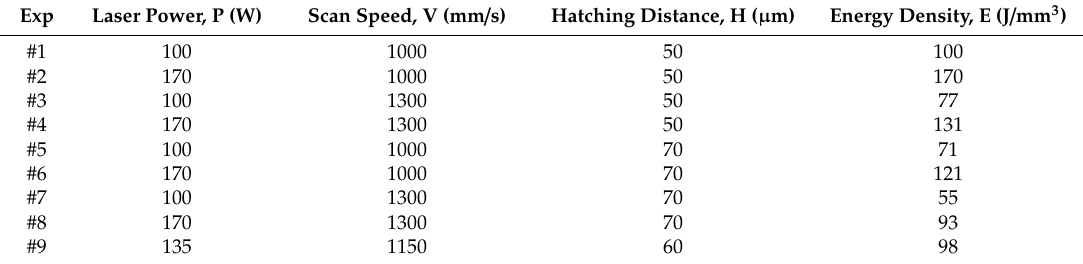
Table 2. Laser powder bed fusion processing parameters used in this study (layer thickness: 20 µ m).